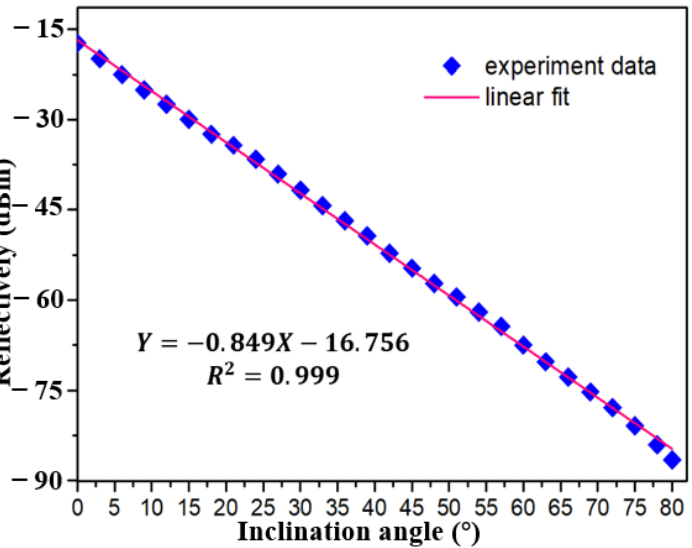
Figure 10. Linear fitting result of the relationship between reflectively and inclination angle in FRL system with step of 10 ◦ with waist equals 86 µ m.